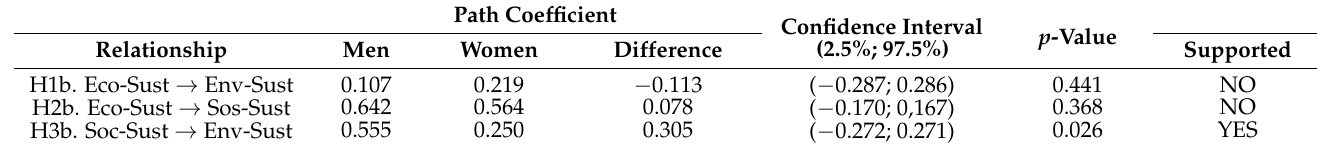
Table 7. Multi-group hypothesis